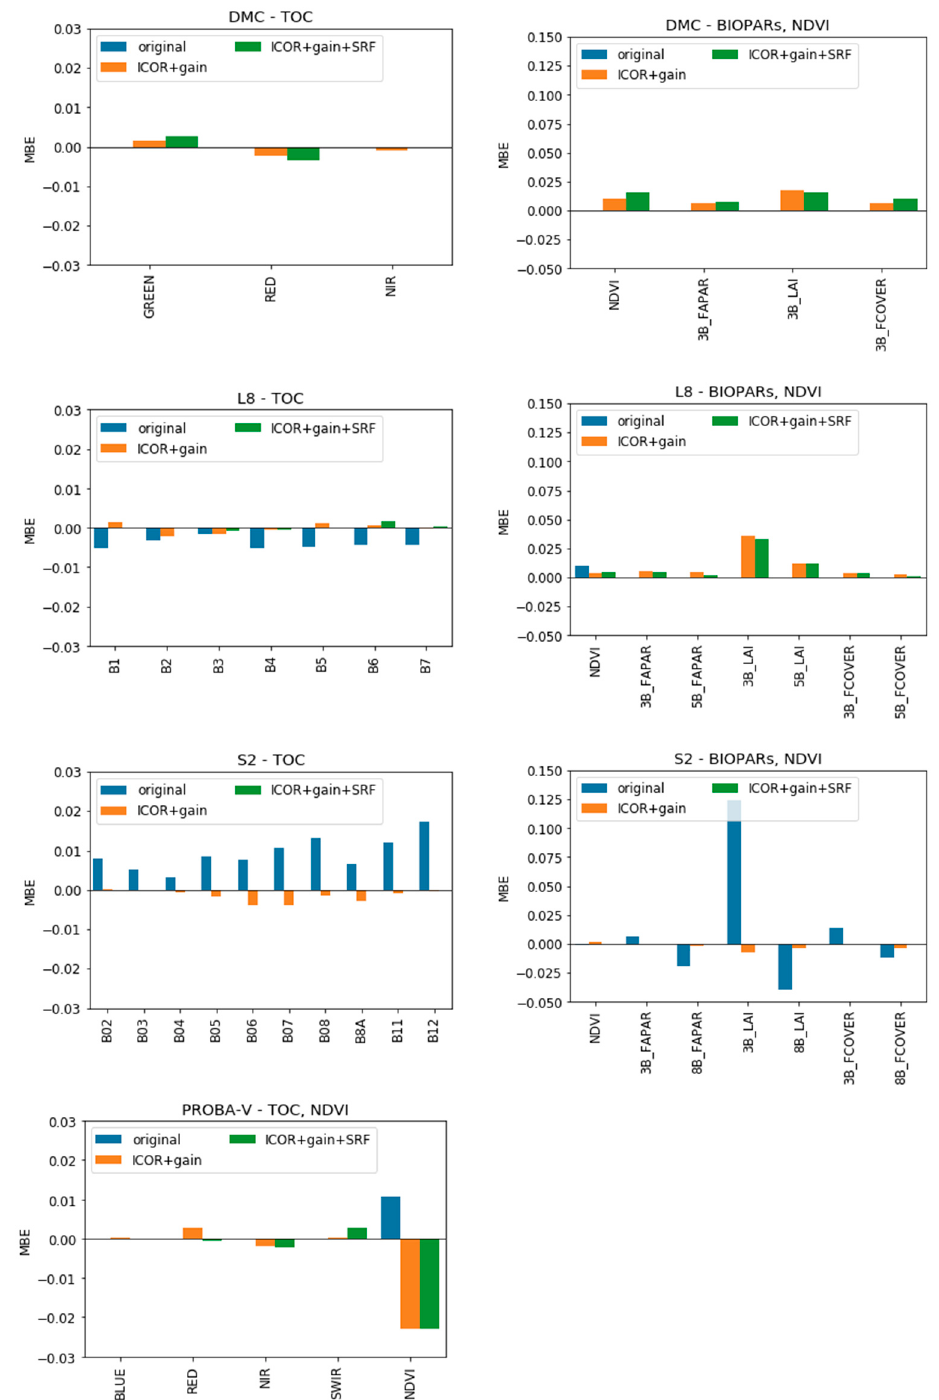
Figure 5. MBE between ICOR and other datasets (colors) per sensor (row), and for TOC reflectances ( left ), and NDVI and BIOPARs ( right ).